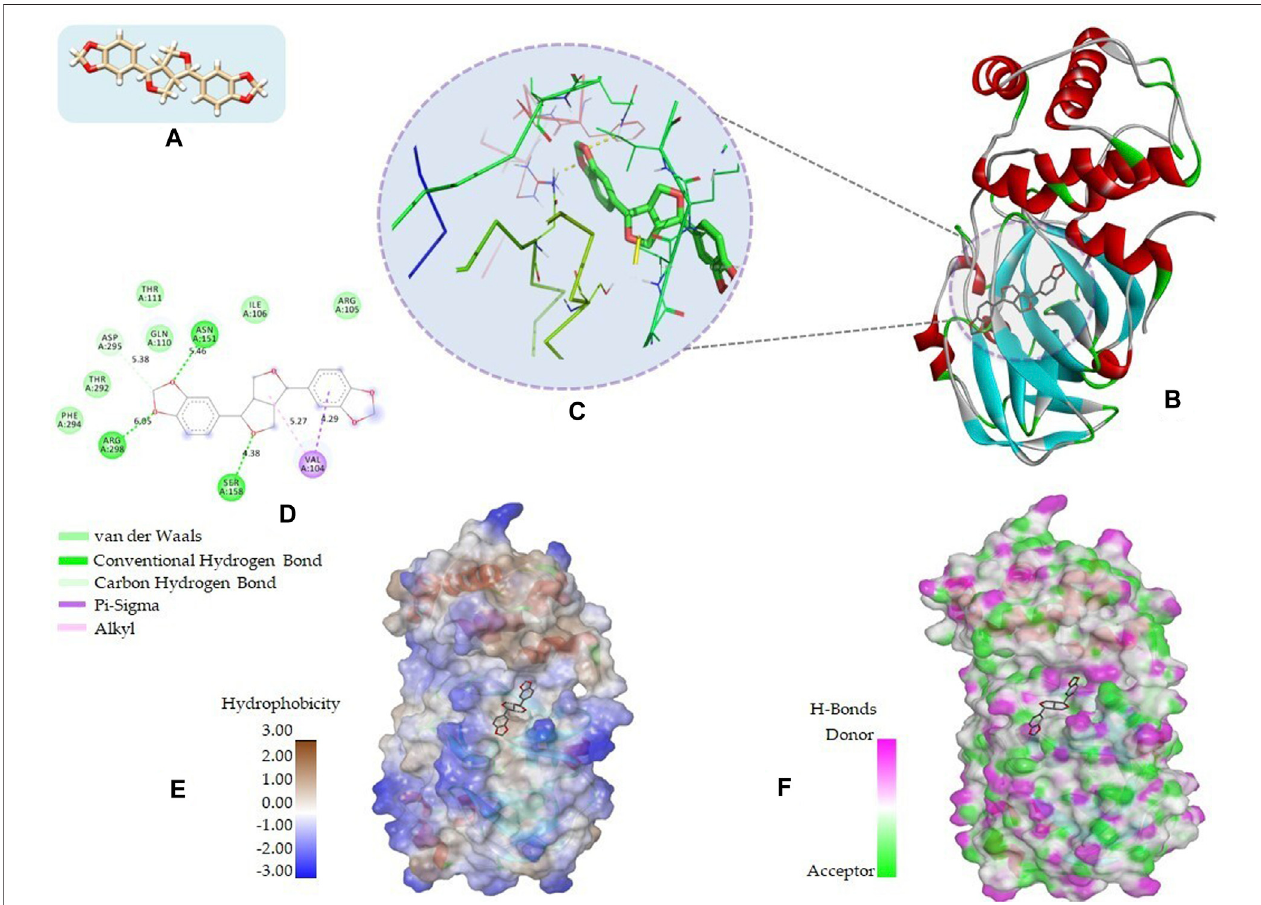
FIGURE 2 | 2D and 3D representation of molecular interaction between the M pro of COVID-19 (PDB ID: 5R7Y) and sesamin compound (CID_72307): (A) 3D structure presentation of sesamin; (B) Molecular docking complex of a crystal structure of M pro with sesamin molecule, docked using AutoDock implemented in PyRx package; (C) close view of pocket with sesamin structure in the stick model colored by atom types, yellow dashed lines represent the hydrogen bond networks; (D) 2D representationofdifferenttypesofinteractionswithsesaminincludingvanderWaals,conventionalhydrogenbond,carbonhydrogenbond,Pi – sigma,andalkyl; (E) hydrophobicitysurfacerepresentationoftheoverallstructureofMproincomplexwithSesamin;and (F) pocketviewofsesaminbindingwithM pro andtherepresentation of residues involved in hydrogen bond donor acceptor. The docking complex of M pro with sesamin was rendered in different CPK using UCSF Chimera, Discovery Studio, and